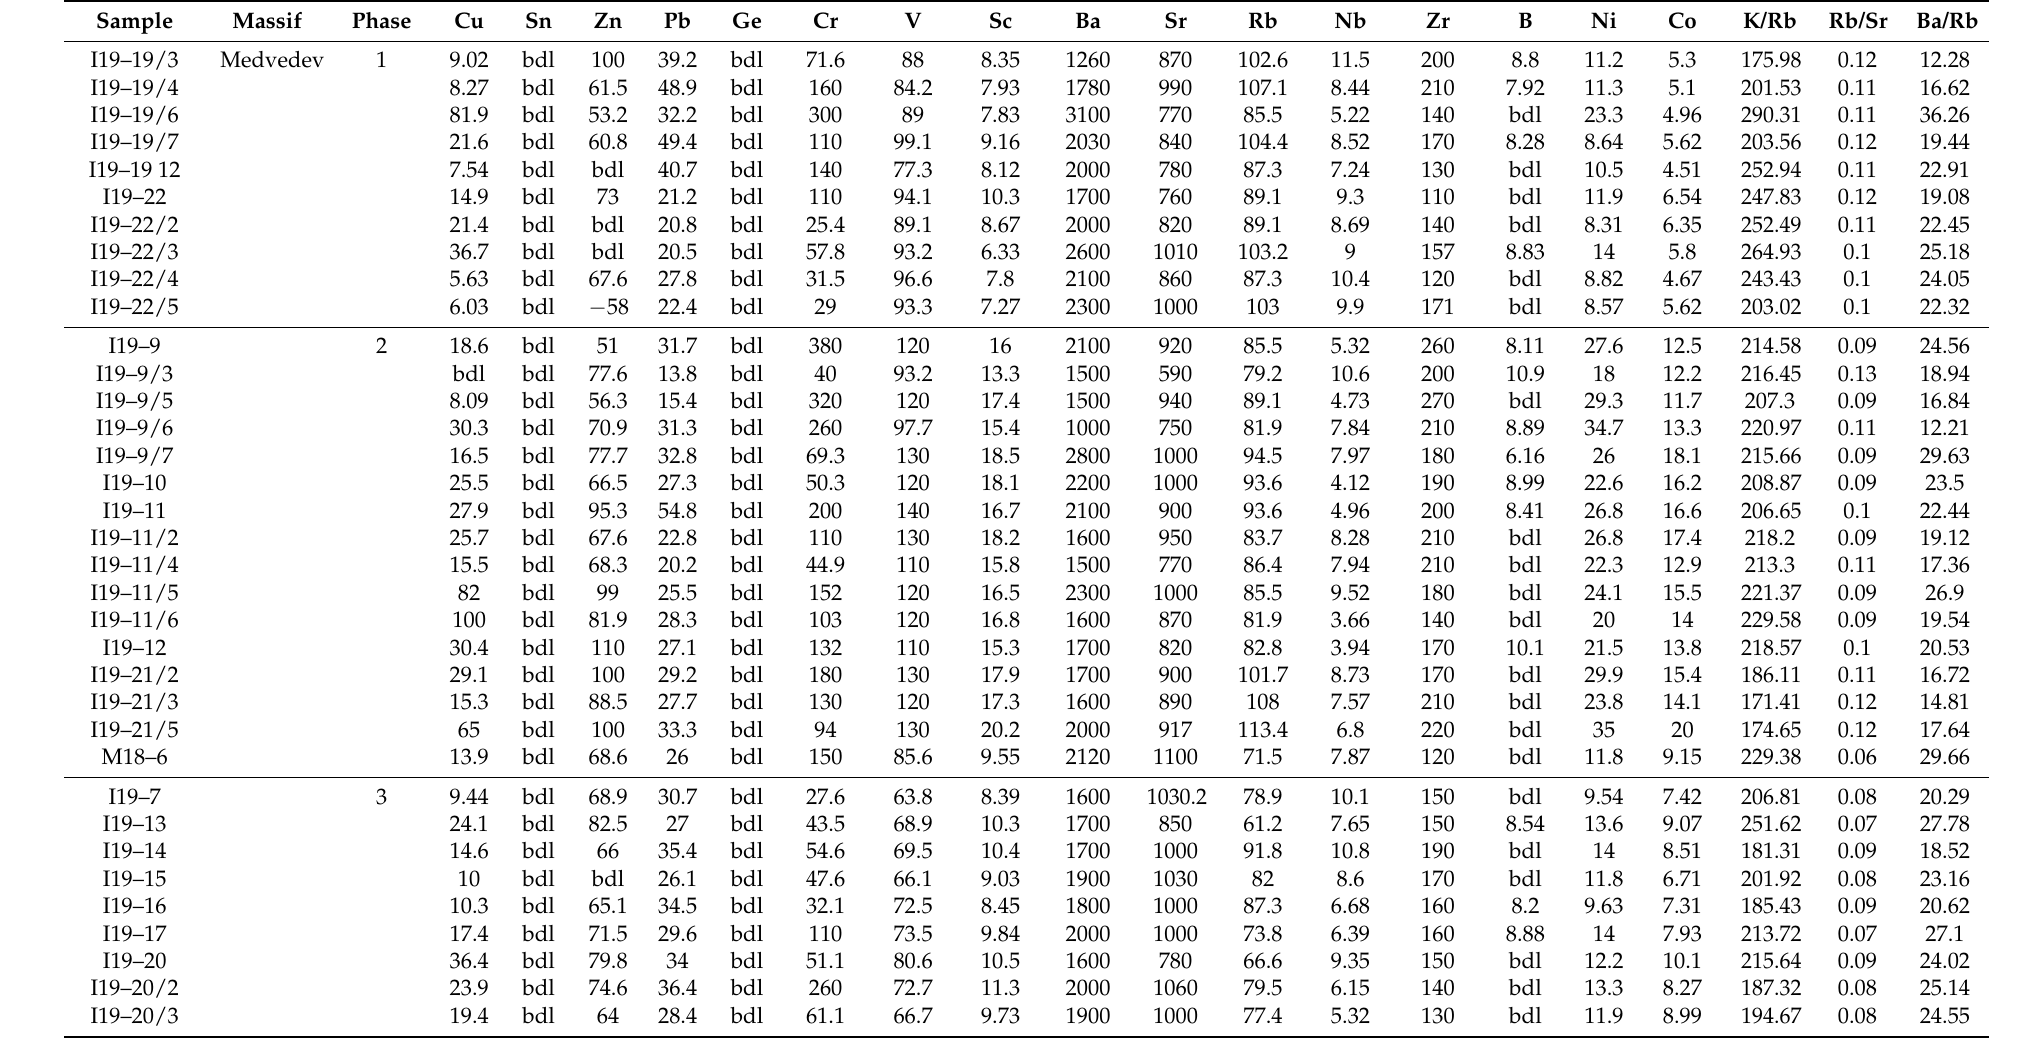
Table A2. Geochemical composition of the igneous rocks of Medvedev and Taezhniy massifs (all values in ppm; bdl—below detection